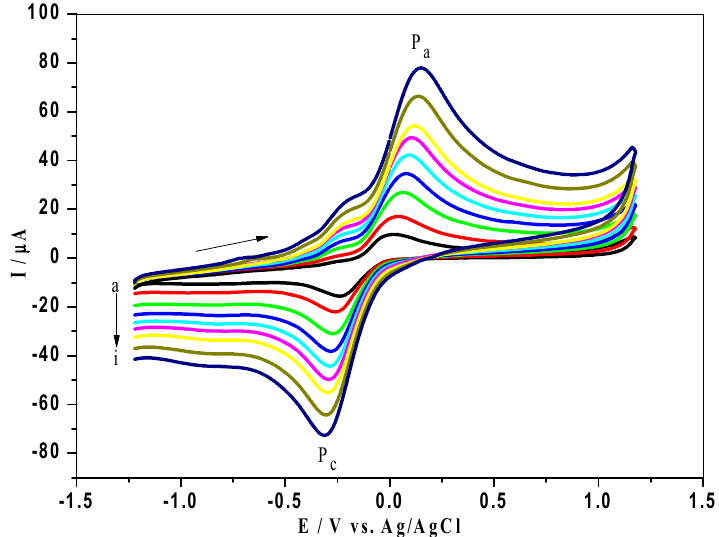
Figure 6. CVs of the Nq/GCE in 0.10 M of PBS (pH 7.0) at various scan rates (a to i: 25, 50, 100, 150, 200, 250, 300, 400, and 500 mV/s).